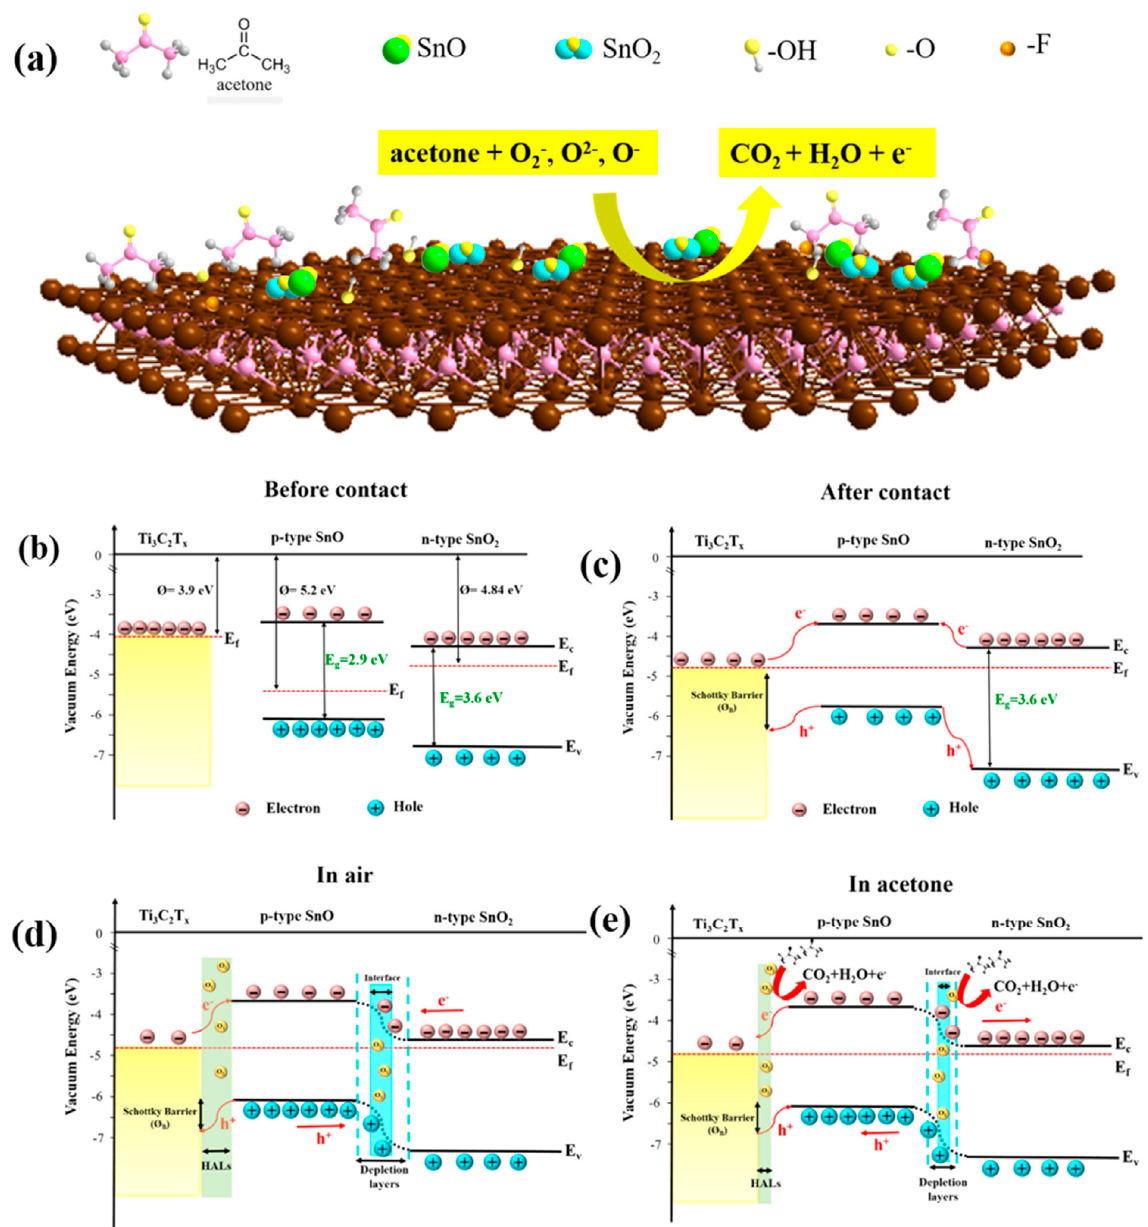
Figure 18. ( a – e ) Schematic diagram of the band structure of p-n hetero-junction and the contact of SnO-SnO 2 /Ti 3 C 2 T x sensor. Reprinted with permission from [112]. Copyright 2021: Elsevier B.V.